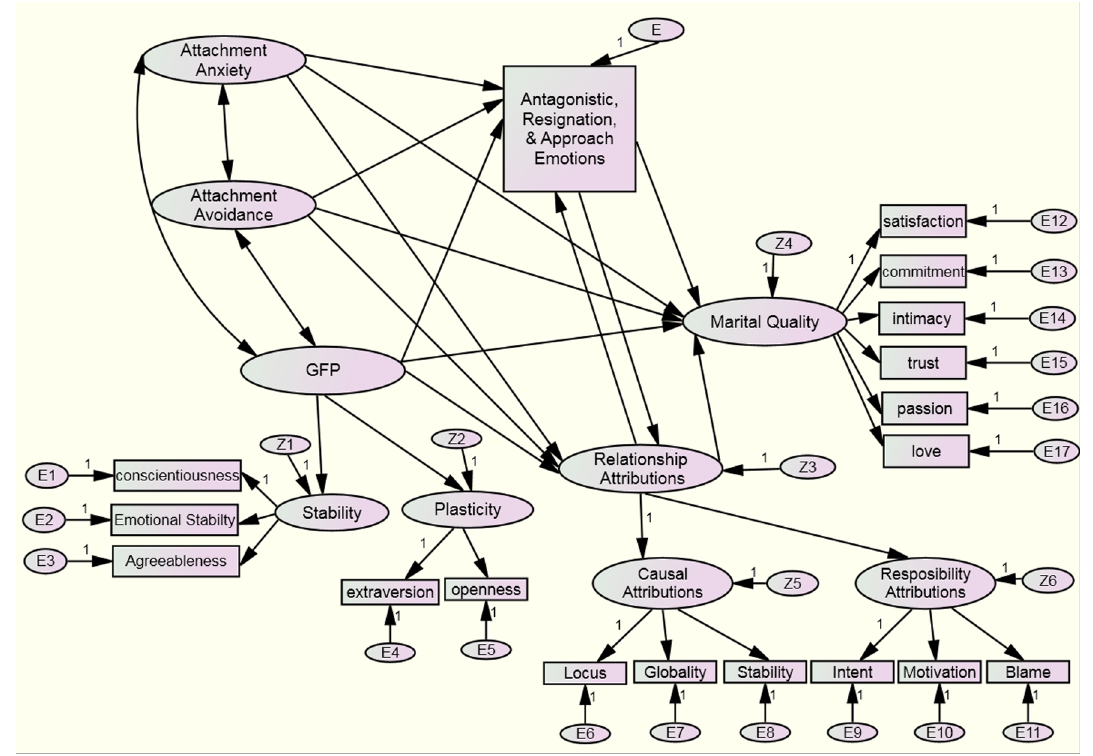
Figure 1. Direct and indirect relationships between attachment anxiety and avoidance, GFP, relationship attributions, emotional reactions, and marital